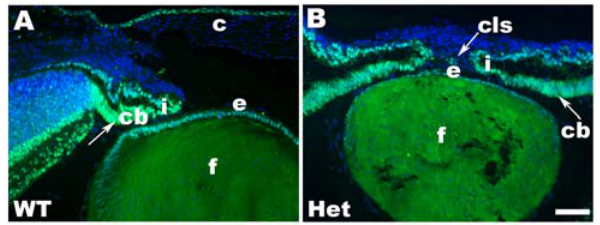
Figure 1. Immunolocalization of Pax6 expression in newborn mouse lens. (A) Expression of Pax6 in wild type (WT) eye. (B) Expression of Pax6 proteins in Pax6 heterozygous (Het) eye. The merged images (light blue) are from nuclear staining, DAPI (blue chanel), and Pax6 (green chanel). Note that development of the ciliary body and iris is delayed in Pax6 + / 2 eye compared to the wildtype. Abbreviations: ciliary body, c; cornea, cb; corneal-lenticular stalk, cls; lens epithelium, e; lens fibers, f; iris, i. Scale bar=50 m